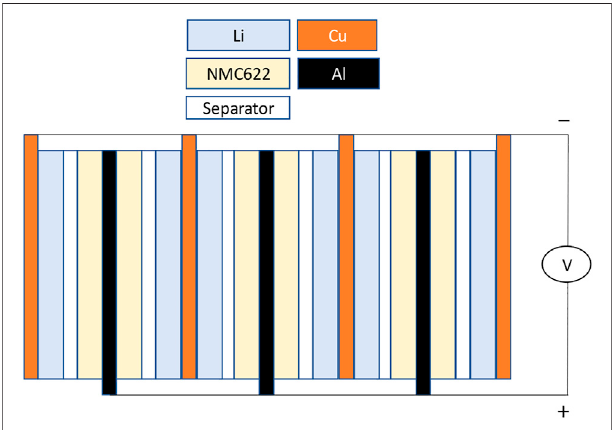
FIGURE 1 | Schematic of the pouch cell used to acquire